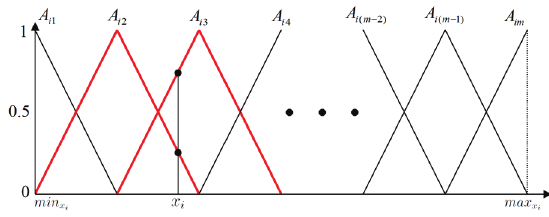
Figure 3. Uniform partition and active membership